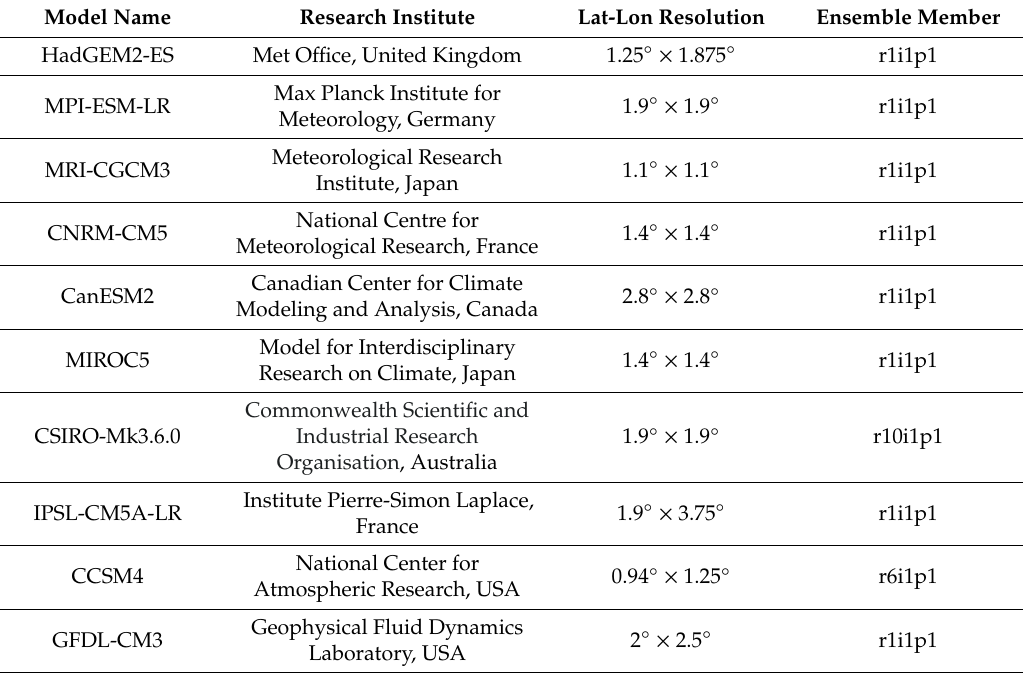
The columns in Table 2 show the: (1) AOGCM name; (2) research institute where the model was developed; (3) resolution for latitude by longitude in degrees; and (4) ensemble member analysed. For all models the historical and Representative Concentration Pathway (RCP) 8.5 (and RCP4.5) sea-level pressure (SLP) outputs are used to calculate daily LWTs for the British Isles